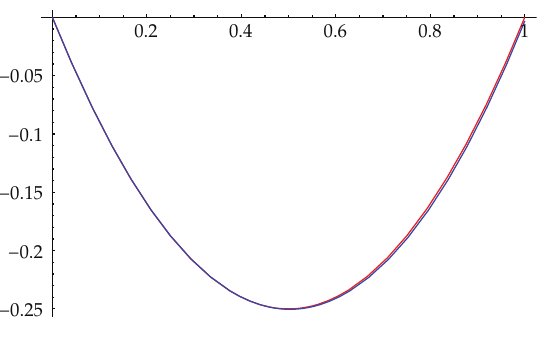
Figure 1: The approximate values U 2 (cid:2) x (cid:3) in comparison with its exact values x (cid:2) x − 1 (cid:3) .